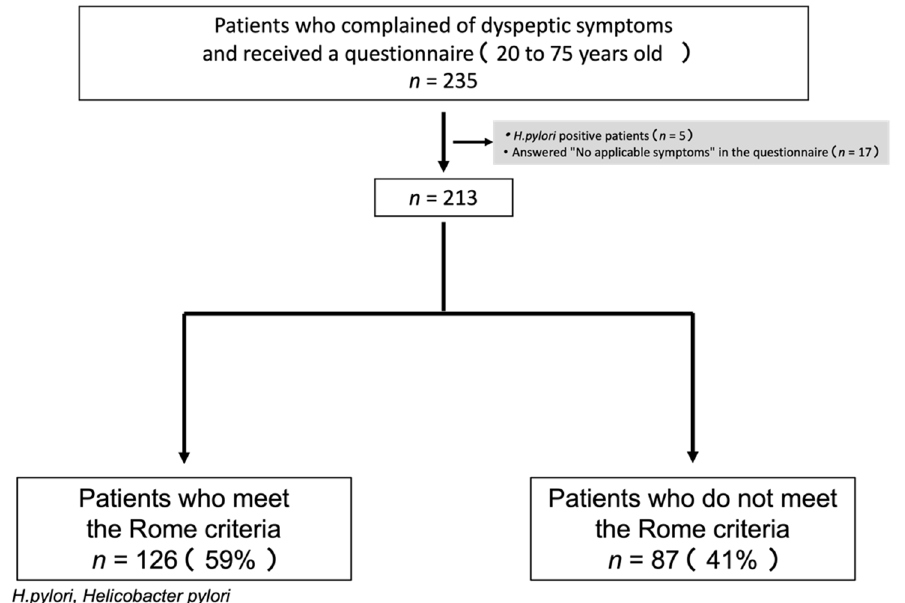
Figure 1. Consort chart. Table 1. Characteristics and symptoms of the